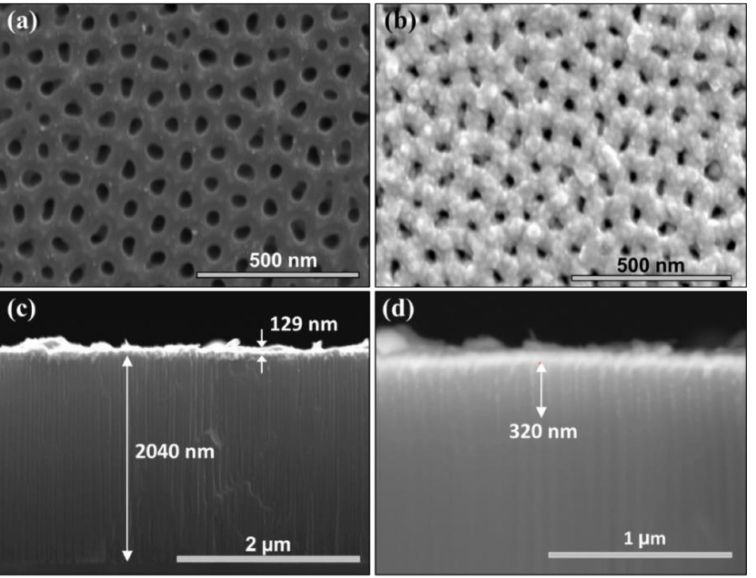
Figure 1. SEM micrographs of a sample synthesized with 5 min of growth time. ( a ) Top view of the pristine sample. ( b ) top view after Au deposition. ( c ) Side view, showing the height of the PAM and the thickness of Au-electrode. ( d ) Backscattered electron image side view, showing the Au penetration inside the